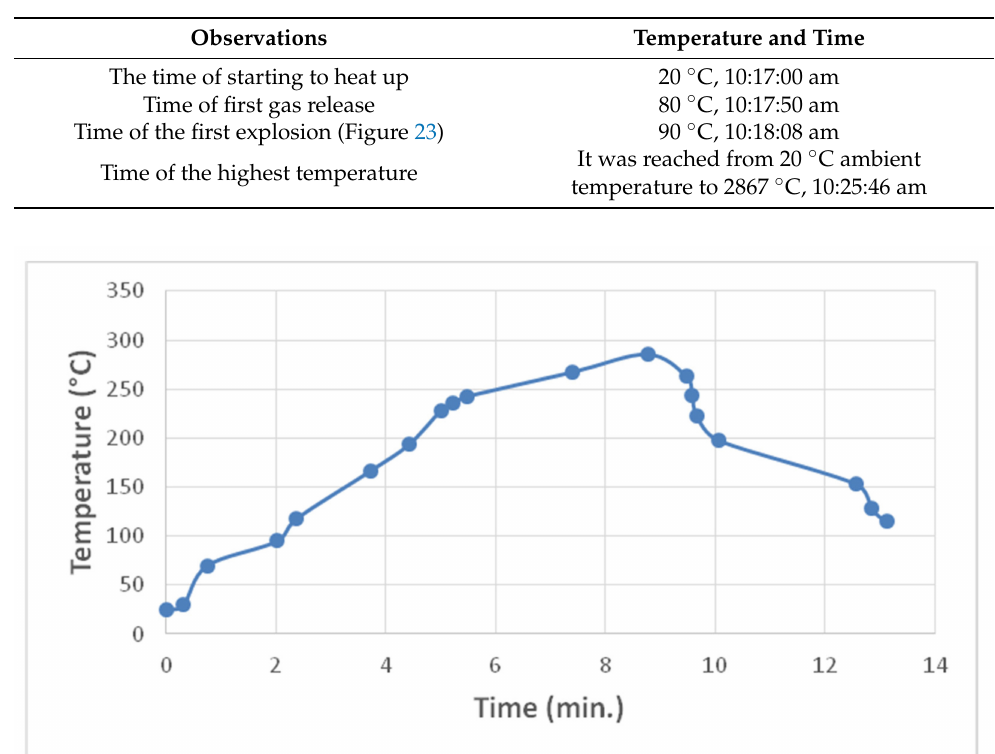
Figure 24. Exp. B.1 results (temperature/time graph). For Exp. B.2 (Figure 25) the temperature at which AUT-BOR would be activated was determined as a set value (75 ◦ C). From the moment the flame detector detected the flame, it recorded this data in the control panel as available. Afterwards, the automatic extinguishing system was activated when the temperature reached the set value of 75 ◦ C (Figure